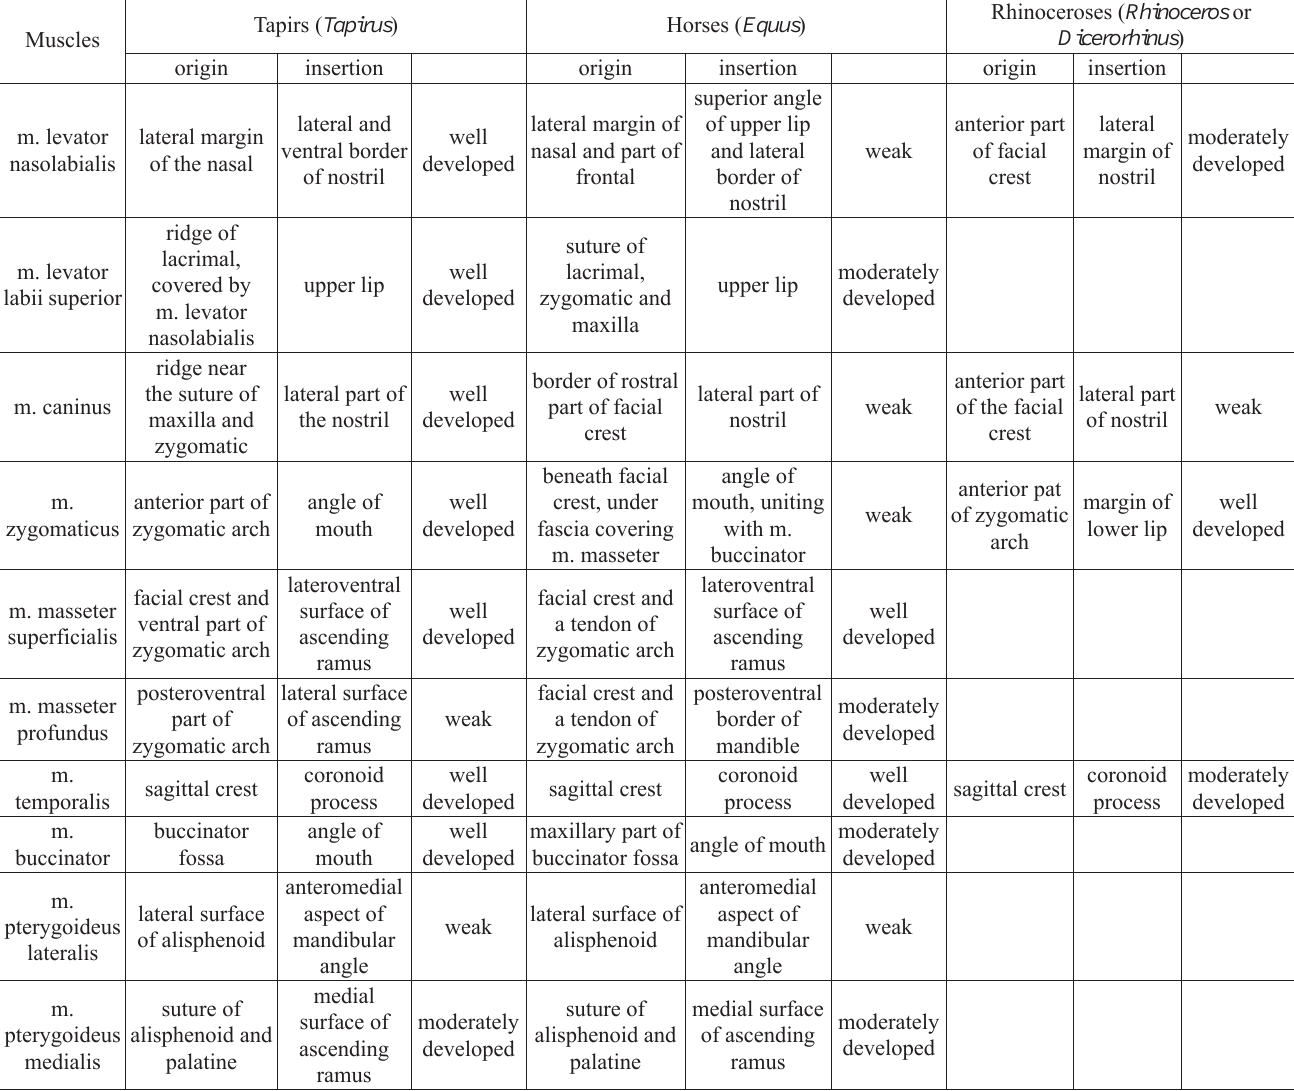
Table 1. Anatomical description of the cranial muscles present in extant horses, tapirs and rhinoceroses.